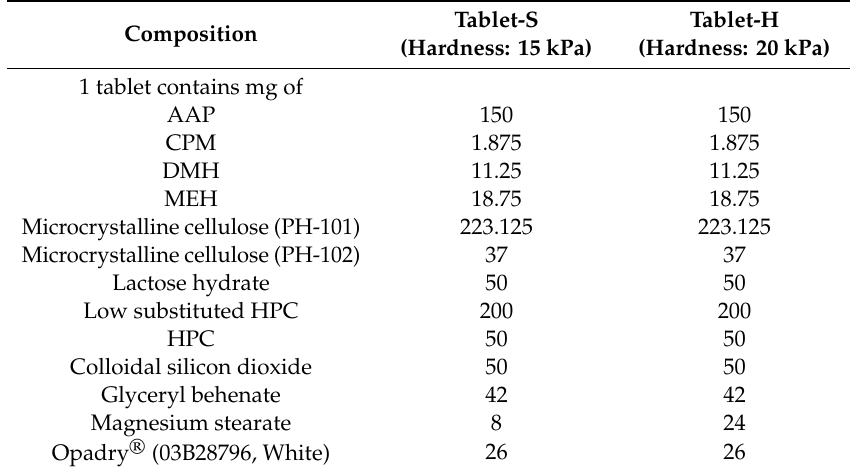
Table 2. Composition of immediate-release (IR) tablets. Composition